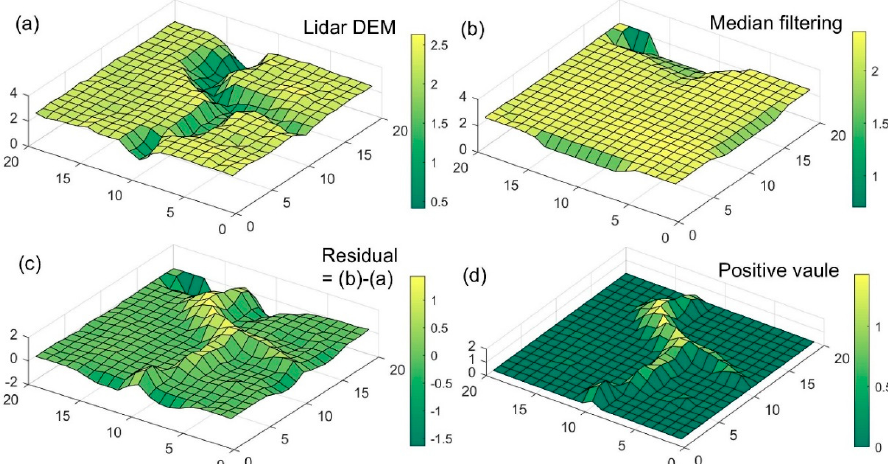
Figure 3. Conceptual graph of MNA. ( a ) Elevation of the original DEM. ( b ) Median filtering (9 × 9 window). ( c ) Residual topography (c = b – a). ( d ) Positive value, namely relative depth.